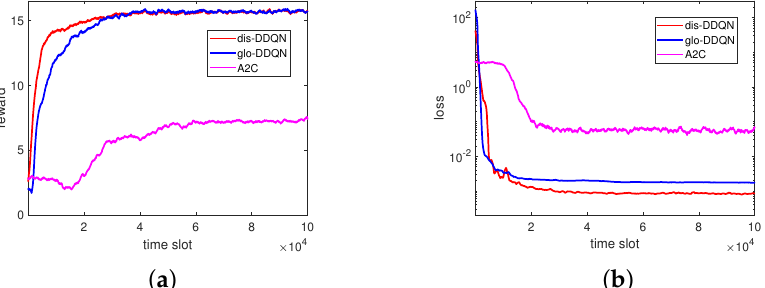
Figure 9. Reward and loss in the RL-based algorithms: ( a ) reward and ( b ) loss.